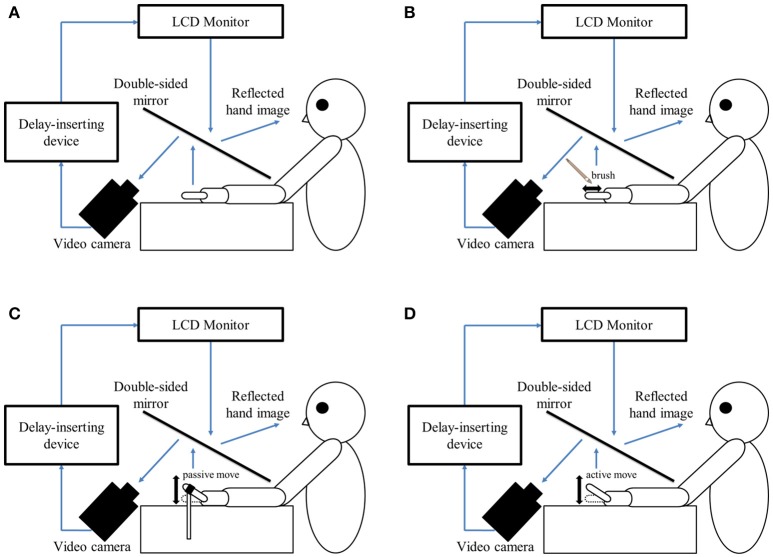
Experimental setup and experimental task. (A) Setup of the experimental task. The patient placed their left hand under a two-way mirror. The patient was able to see their left hand projected on a two-way mirror. (B) Tactile stimulation condition. The patient's left index finger was stimulated tactilely by a brush. (C) Passive movement condition. The patient's left index finger was moved passively. (D) Active movement condition. The patient moved their left index finger under their own volition. The finger was filmed by a video camera under all conditions (B–D). Visual feedback delay was achieved using a hardware device. The patient observed the reflected image of their delayed finger displayed on an LCD monitor. For each trial of each stimulation condition, the patient was instructed to reply orally “delayed” or “not delayed” by the forced-choice method immediately following the trial.